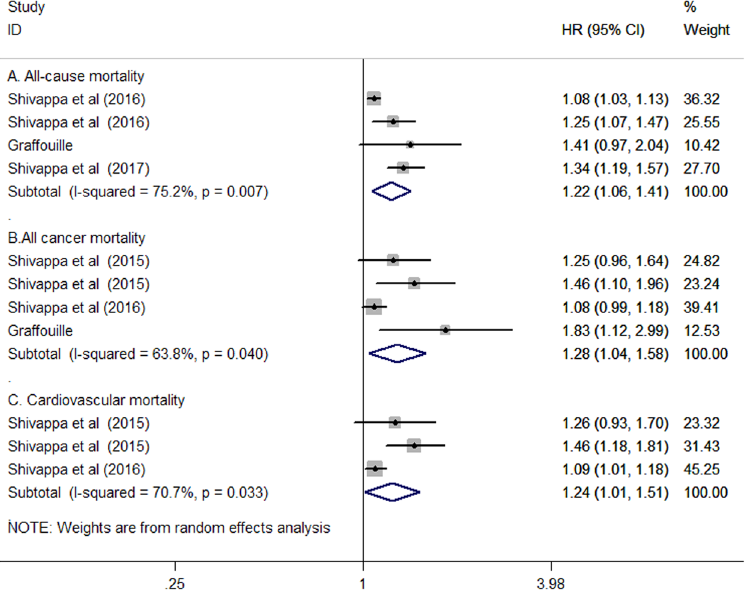
Figure 2. Forest plots showing HR with 95% CI of all-cause mortality (A), cancer-related mortality (B), and cardiovascular mortality (C) comparing the highest to the lowest dietary inflammatory index score.